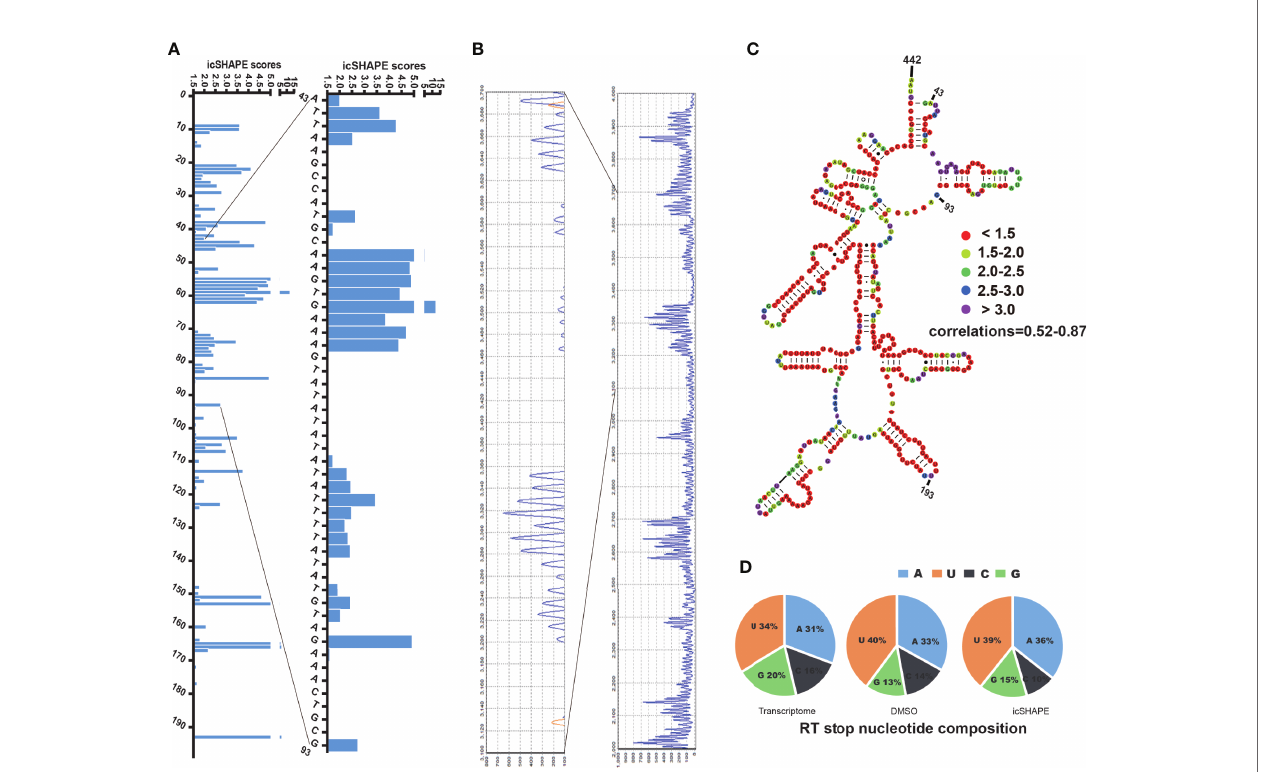
FIGURE 1 | icSHAPE scores accurately maps the region 43 – 442bp of P. falciparum 18S small subunit rRNA (blood stage) icSHAPE scores accurately maps the region 43 – 442bp of Plasmodium falciparum 18S small subunit ribosomal RNA (blood stage) and agrees with capillary electrophoresis-based in vivo structure probing. (A) icSHAPE scores for nucleotides 1-193 is shown on the left. The sites of nucleotides which showed have the scores above 1.5, this score means this position is single-strand. (B) The gel from 18S A-type rRNA NAI-N 3 modi fi cation read-out by capillary electrophoresis-based probing, which was done here near the 5 ’ end (100bp-300bp), which consist with the region on the 1-193 of the 18S rRNA. (C) Nucleotides 43 – 442 of the 18S A-type small subunit ribosomal RNA, colour- coded according to icSHAPE scores. The whole secondary structure of 18S A-type small subunit ribosomal RNA are showed in Supplementary Figure 3 . (D) Reverse transcription stop distribution for the transcriptome of 18S A-type rRNA on chromosome 5, DMSO-treated RNA control libraries or icSHAPE-treated RNAs libraries in the same regions of 18S rRNA. All of the three stop distributions are highly concordant, icSHAPE in vivo treatment no enriches for any sequencing reads mapping to four bases compared to untreated control, except a slight enrichment in NAI-N 3 library for As and